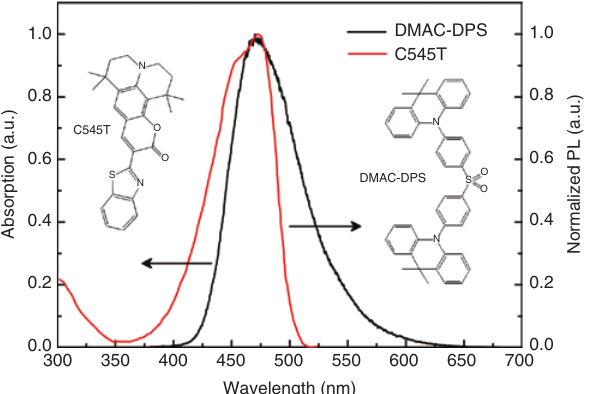
Figure 2: The PL spectrum of DMAC-DPS and absorption spectrum of C545T.